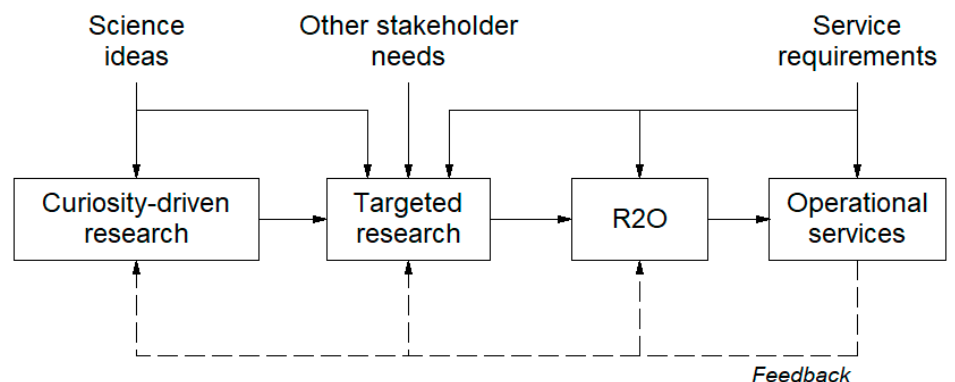
Figure 1. An outline of how ideas might flow in a diverse scientific culture as discussed in this paper. The research progresses, left to right, from curiosity-driven research to operational services, but the intermediate steps are vital and need dedicated processes to ensure that progress. Those processes must encourage scientists to engage not only with end users such as service operators, but also other stakeholders such as government agencies responsible for the regulation and resilience of